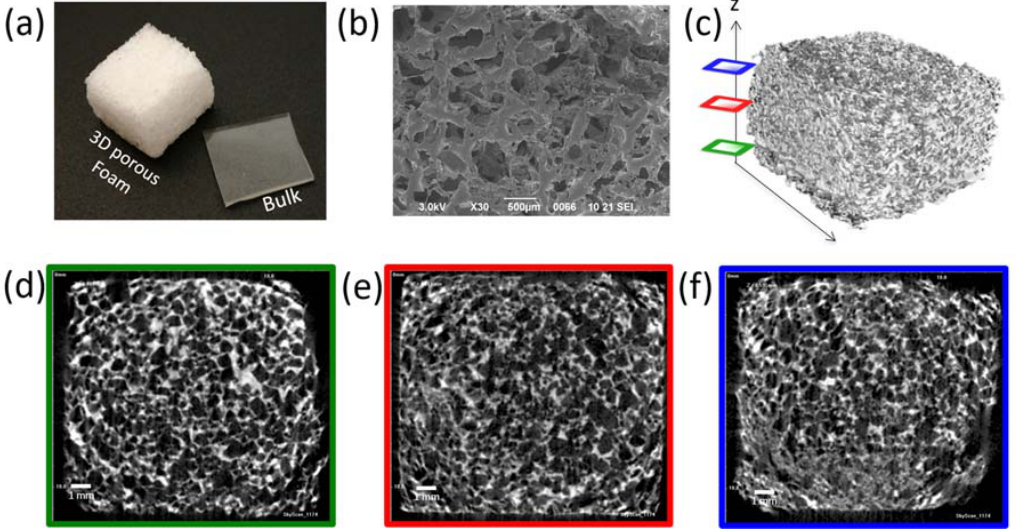
Figure 1. Morphological characterization of the 3D porous PDMS foam obtained by the sugar templating process: ( a ) Optical picture, ( b ) SEM image and, ( c ) 3D volume reconstruction and ( d – f ) cross-sectional profiles at different heights (z b = 0.86 mm, z c = 4.12 mm and z d = 8.60 mm, z max = 9.0 mm) obtained by micro CT analysis.